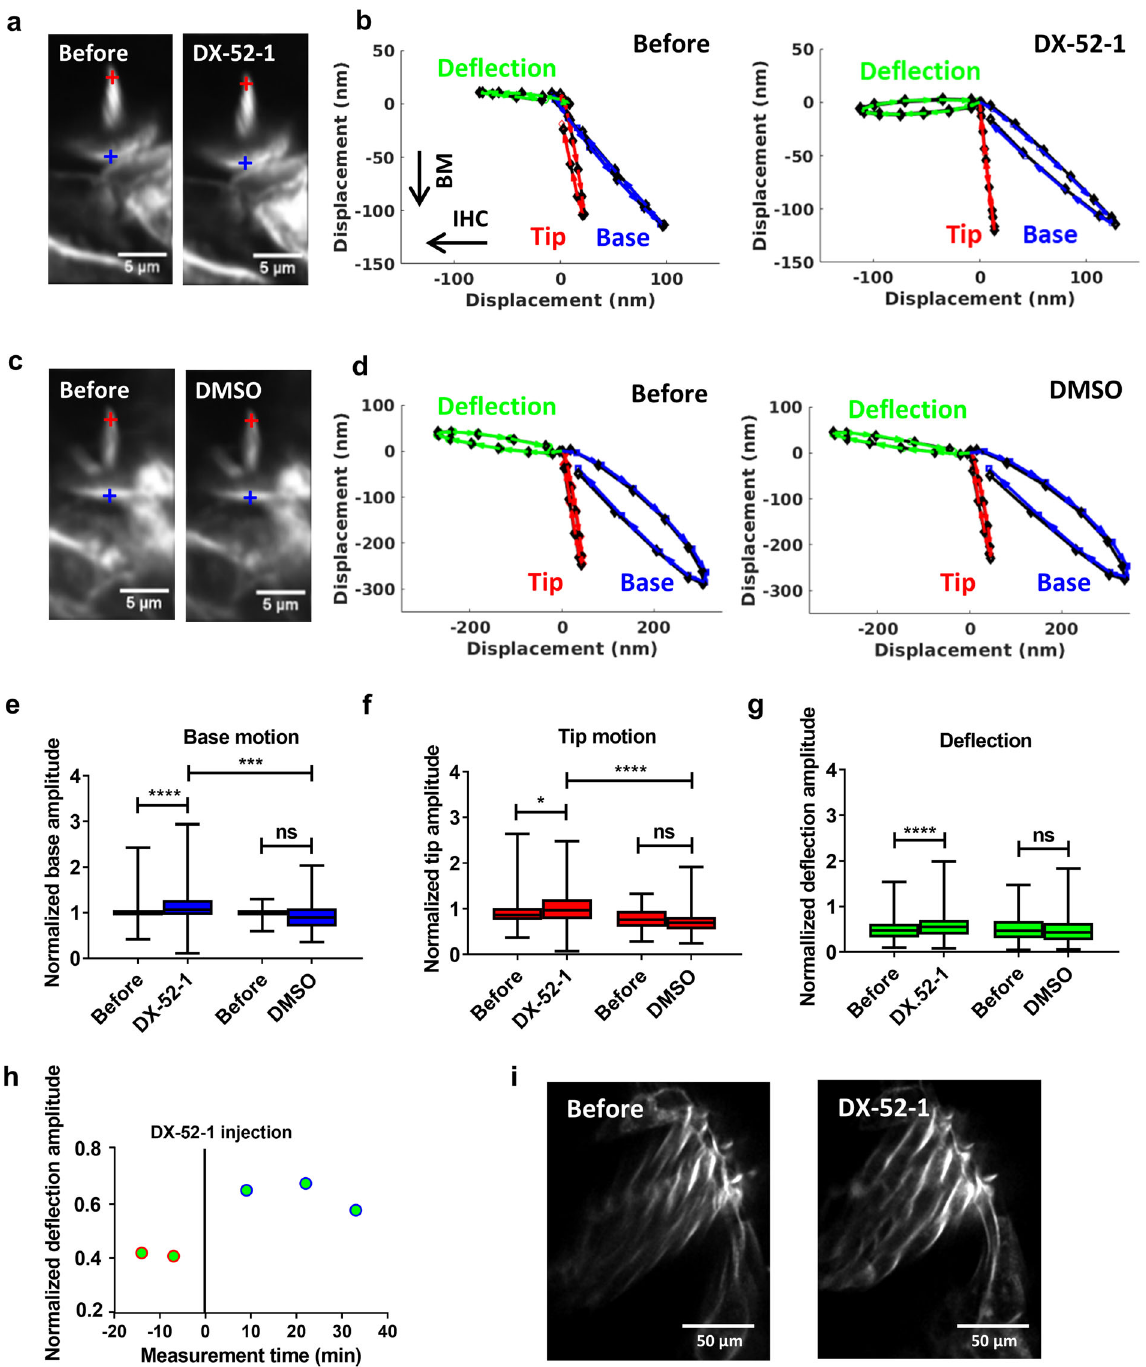
Fig. 3 DX-52-1-induced effects on sound-evoked motions of outer hair cell stereocilia. a Time-resolved confocal images acquired during sound stimulation show that DX-52-1 does not alter the morphology of stereocilia (except for a small change in the brightness of the fl uorescent dye). b Sound- evoked motion of the bundle tip (red) and base (blue) before and after DX-52-1 injection in an example preparation. The stimulus was a pure tone at 220 Hz and 80 dB sound pressure level. By subtracting trajectories from the tips and bases of stereocilia, a measure of the de fl ection of the bundle is obtained (green). c Confocal image obtained after DMSO injection, showing lack of effect on stereocilia morphology. d No change in the motion of the bundle tip (red) and base (blue) before and after DSMO injection observed along with absence of change in de fl ection (green). e – g Averaged bundle motion change at the base of outer hair cell stereocilia (blue bar), at their tip (red bar) and the de fl ection of the bundle (green bar). Data were normalized to the base trajectory amplitude recorded before the injection. Averaged data from 70 (DX-52-1) and 15 (DMSO) individual preparations ±standard deviation. h Time course of de fl ection amplitude of outer hair cell bundles (blue circle) in an example preparation. The vertical line at time zero indicates the time of injection. Data were normalized to the average trajectory amplitude recorded before injection. i High-resolution confocal images of stereocilia in preparations treated with DX-52-1 or vehicle show no detectable morphological changes. **** P < 0.0001; *** P < 0.001; ** P < 0.01; * P < 0.05; n.s., not signi fi cant; two-tailed paired t -test, two-tailed unpaired t -test with Welch ’ s